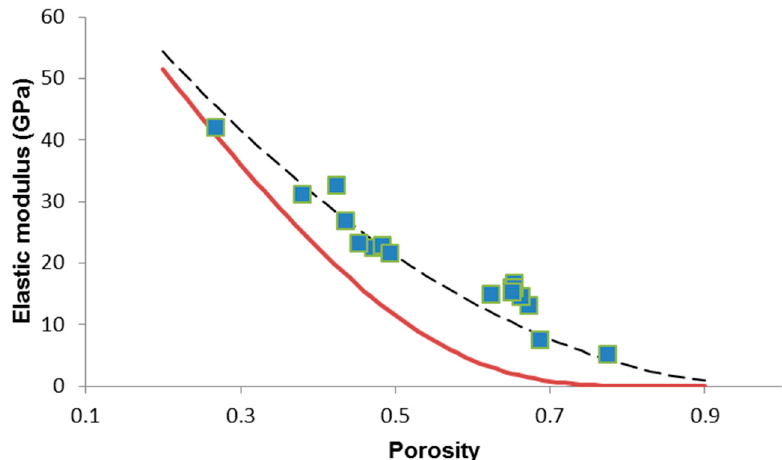
Figure 4. Porosity dependence of elastic modulus in CEL2 glass-derived foams with data interpolation by applying the Gibson–Ashby power-law model (Equation (4)) (dashed line) and the Pabst–Gregorova exponential relation (Equation (6)) (solid line). Raw data from Reference [41].